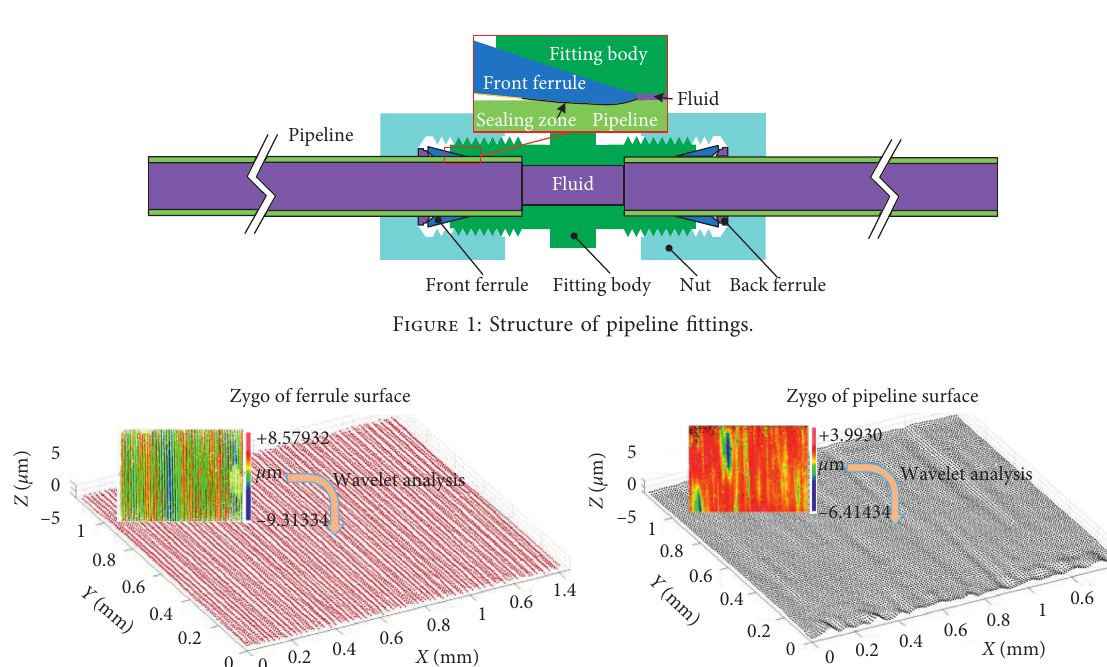
Figure 2: Zygo test and surface morphology of ferrule and pipeline after wavelet analysis.